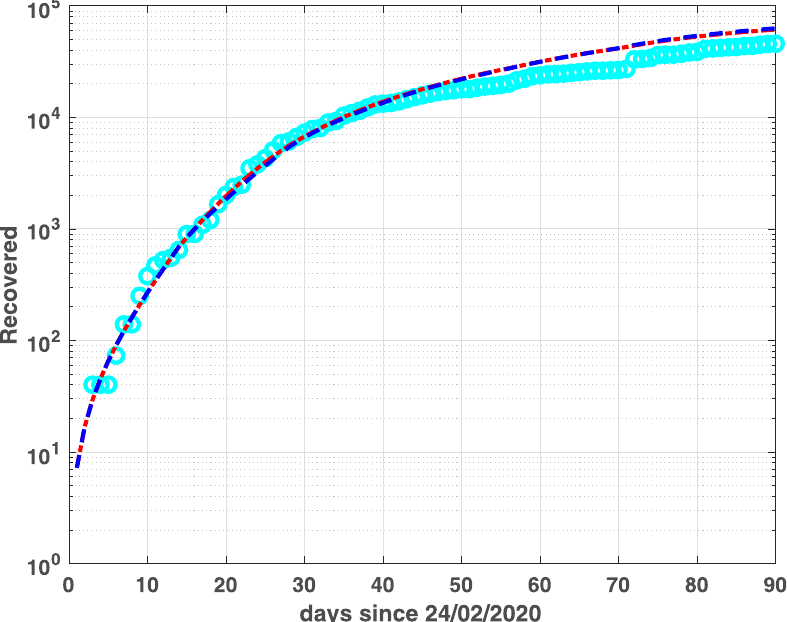
Fig 6. Recovered compartments for Lombardia. Recovered data (cyan dots) and Recovered modelled population, obtained by fSEIRDr (blue dash-dotted line) and fSEIDRe (red dashed line).